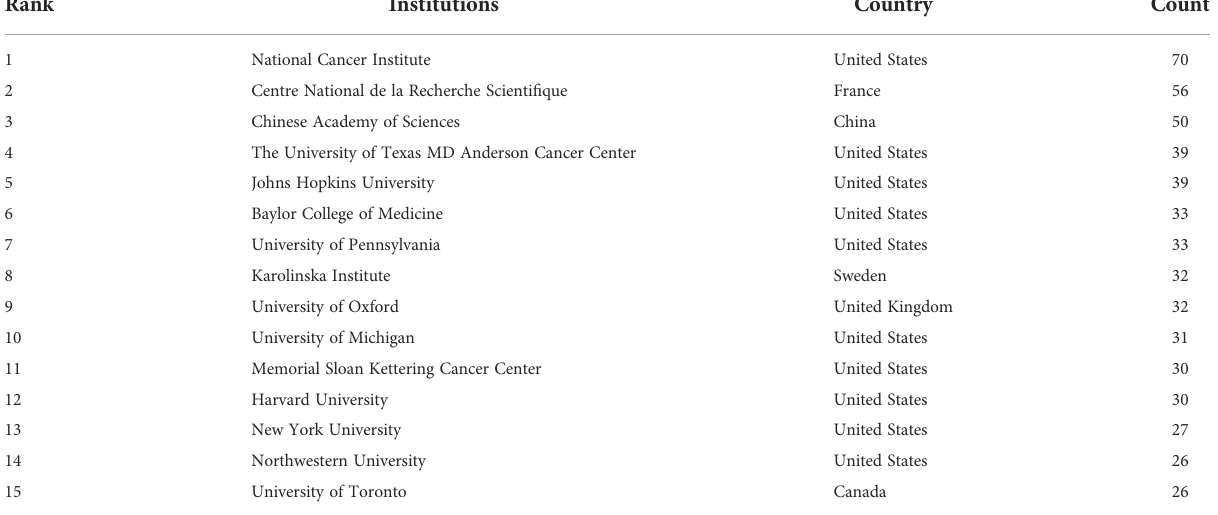
TABLE 1 The top 15 institutions involved in PTMs of cancer fi eld. Rank